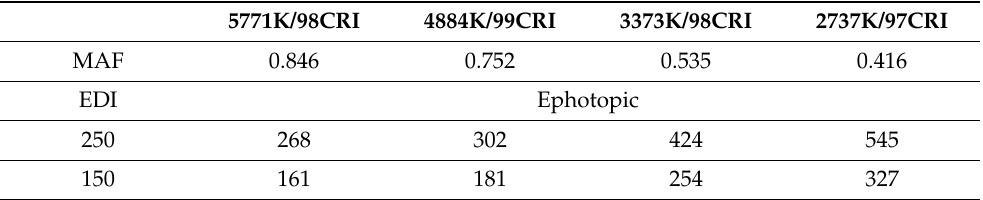
Table 6. Photopic illuminance at the corneal level needed to provide 250–150 m-lux with four